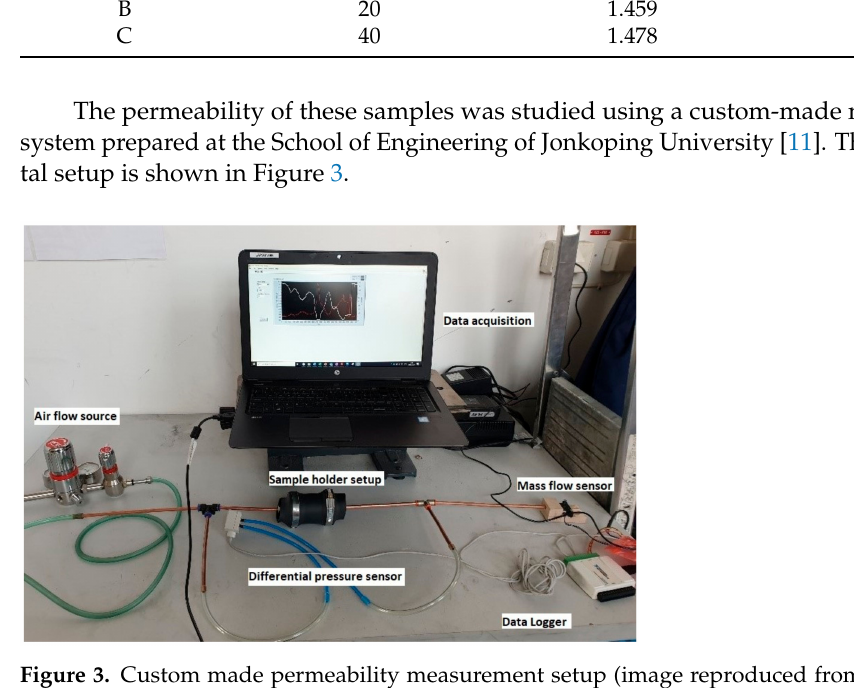
Figure 3. Custom made permeability measurement setup (image reproduced from international journal of cast metals research, published by Taylor and Francis, 2021)